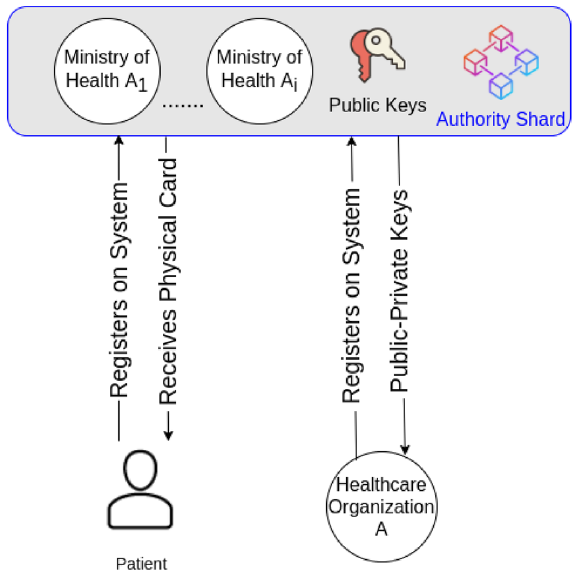
Figure 8. Authority